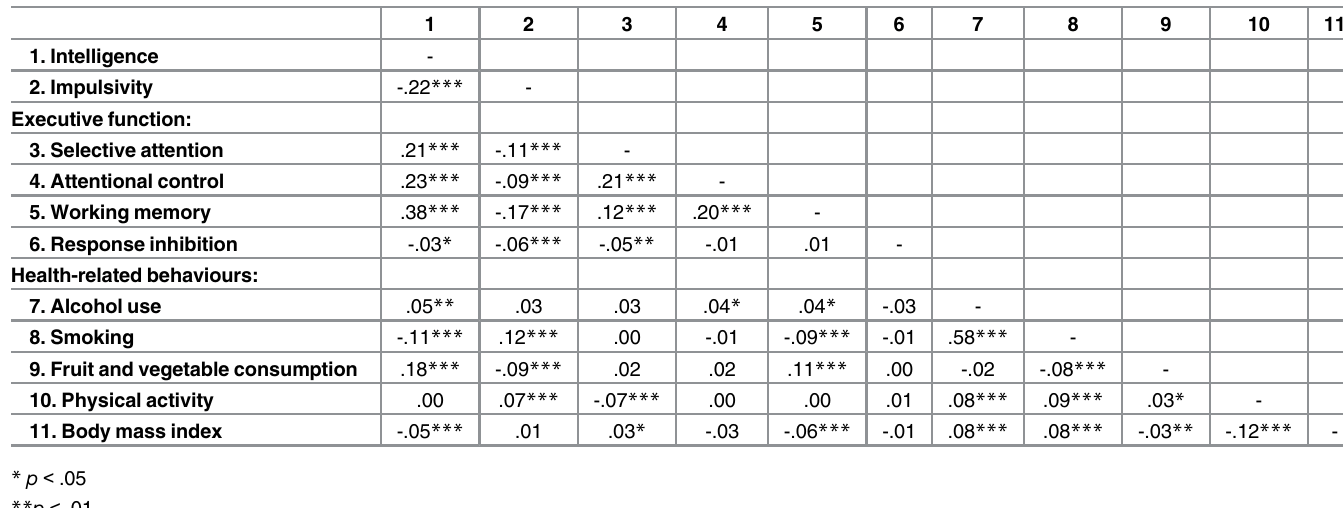
Table 4. Pairwise correlations between cognitive variables and health-related behaviours.